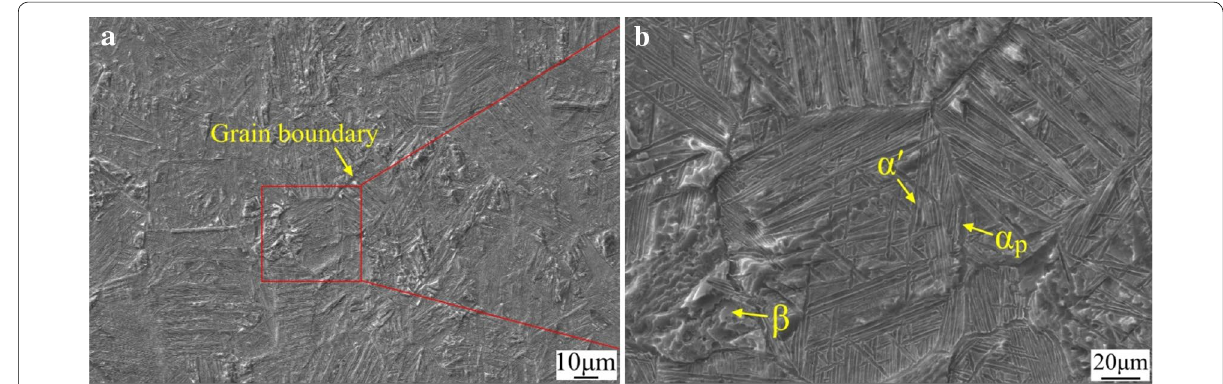
Figure 6 Typical microstructure of weld zone: a Low magnification, and b high